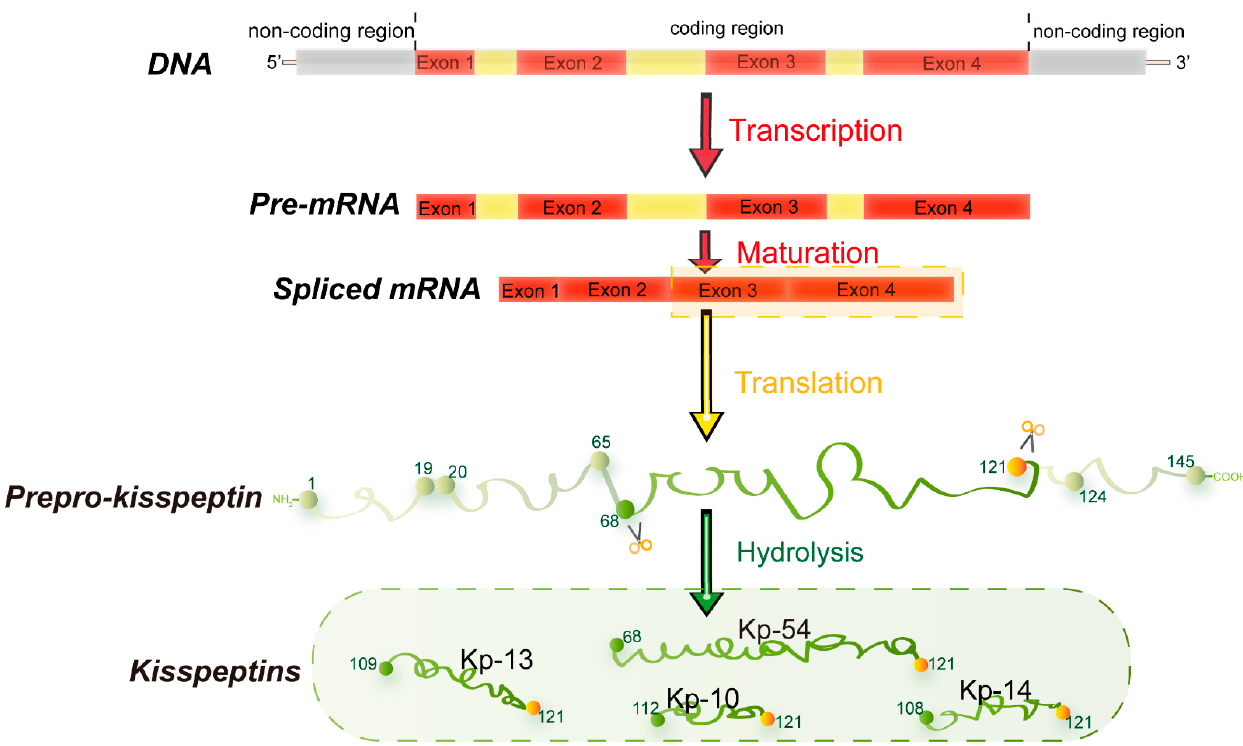
Figure 1. Major structural features of human kisspeptin gene. The human Kiss1 gene consists of four exons, the last two encoding a precursor protein translated into a 145 amino acid. This precursor protein includes a predicted signal peptide of amino acids 1-19, a potential dibasic cleavage site of amino acids 65-68, and a terminal cleavage and amidation site of amino acids 121-124. It can be fragmented into different lengths of kisspeptin with a common amidated C-terminal (KP- 54/14/13/10) [7].